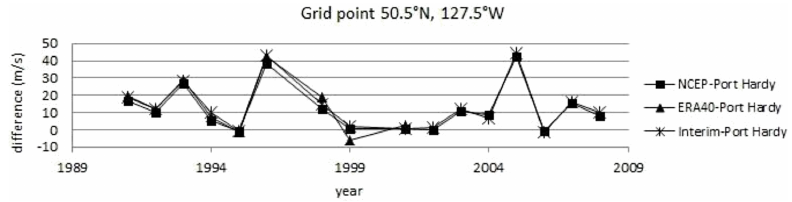
Fig. 7. Differences in February average wind speeds between reanalysis at the grid point of ERA-Interim 49.5 ◦ N, 127.5 ◦ W and Port Hardy station, at 10hPa.